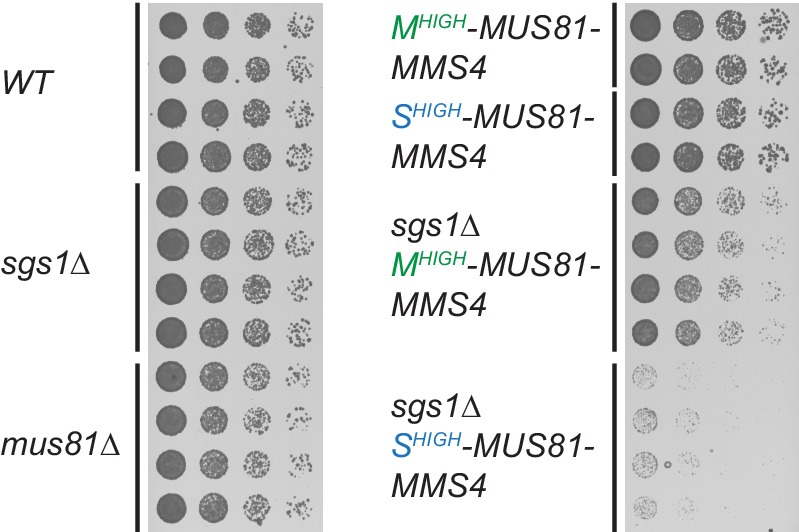
Mus81 function during M phase is required in the absence of Sgs1 function.Growth assay of yeast haploid cells with the indicated genotypes derived from the tetrad analysis of Shigh-/Mhigh-Mus81-Mms4 in Figure 4E including very slow growing Shigh-/Mhigh-Mus81-Mms4 sgs1∆ haploids. Four strains of indicated genotypes were spotted in 5-fold serial dilutions and growth was analysed after incubation of 1.5 days at 30°C on YPD plates.